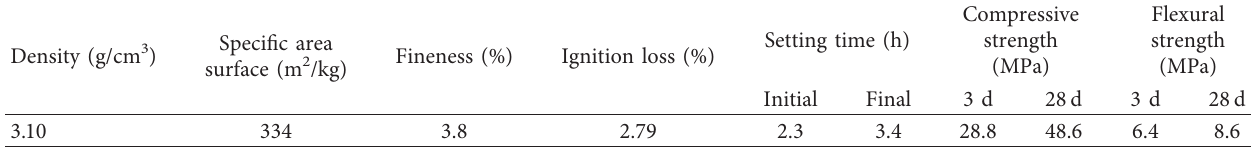
Table 2: Physical and mechanical properties of cement.